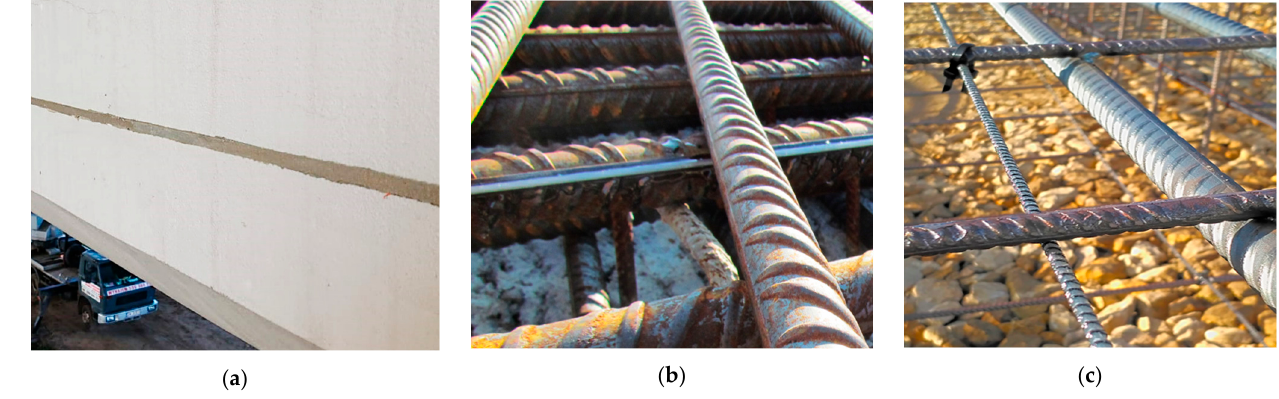
Figure 7. Possibilities of the sensors’ installation methods: ( a ) installation in near-to-surface grooves; ( b ) surface gluing (on steel bar); ( c ) embedding inside the concrete. The most convenient way of installation is applied in the new, reinforced